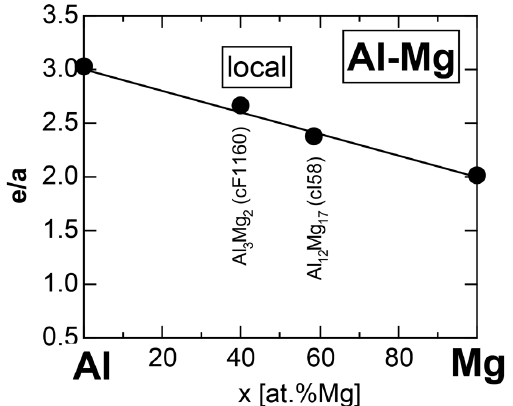
Figure 53. Composition dependence of e/a for compounds in Al-Mg alloy system [11].